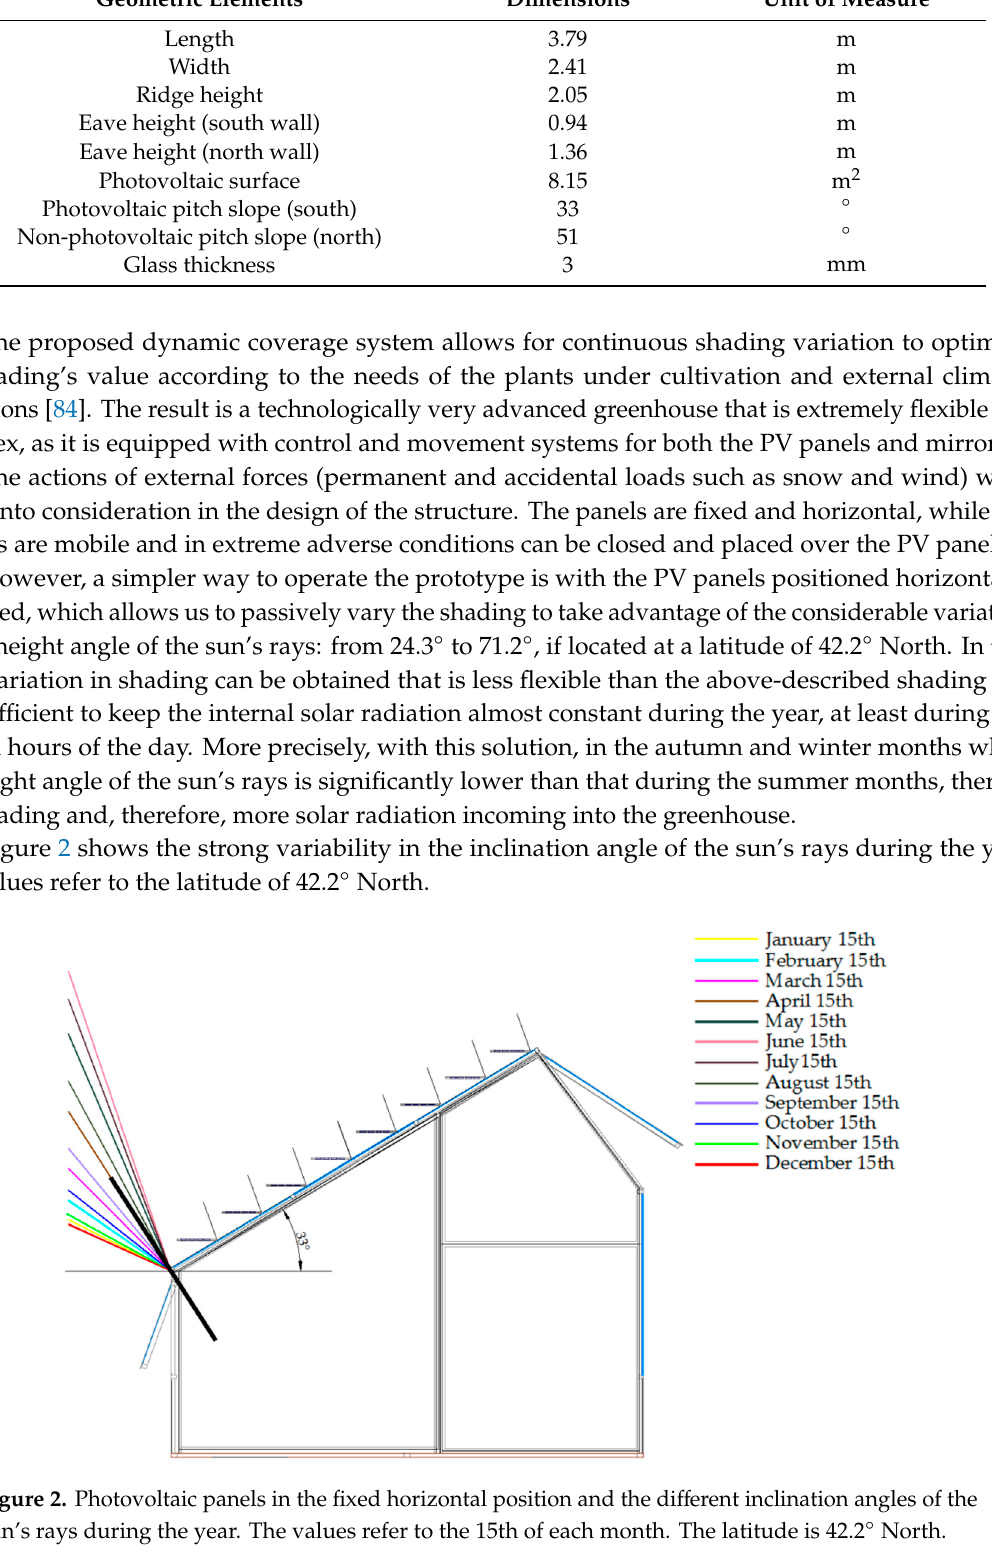
Table 1. Geometric characteristics of the prototype greenhouse.